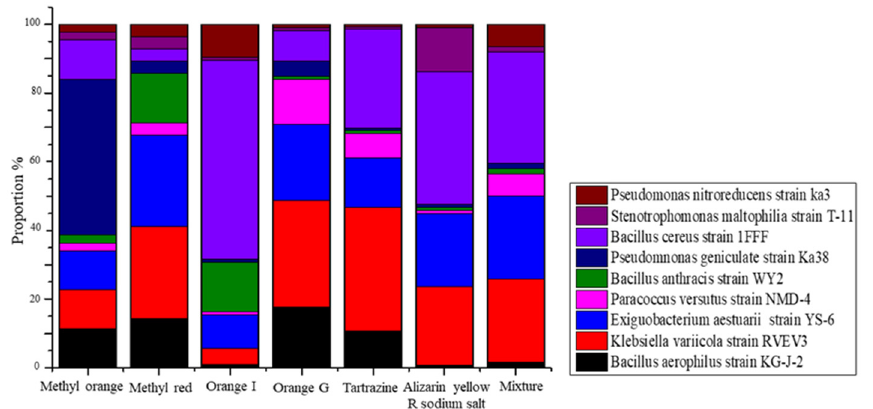
Figure 4. Comparison of cultured microbial community structures from activated sludge after acclimatization with different azo dyes. For better understanding, a color view is recommended.